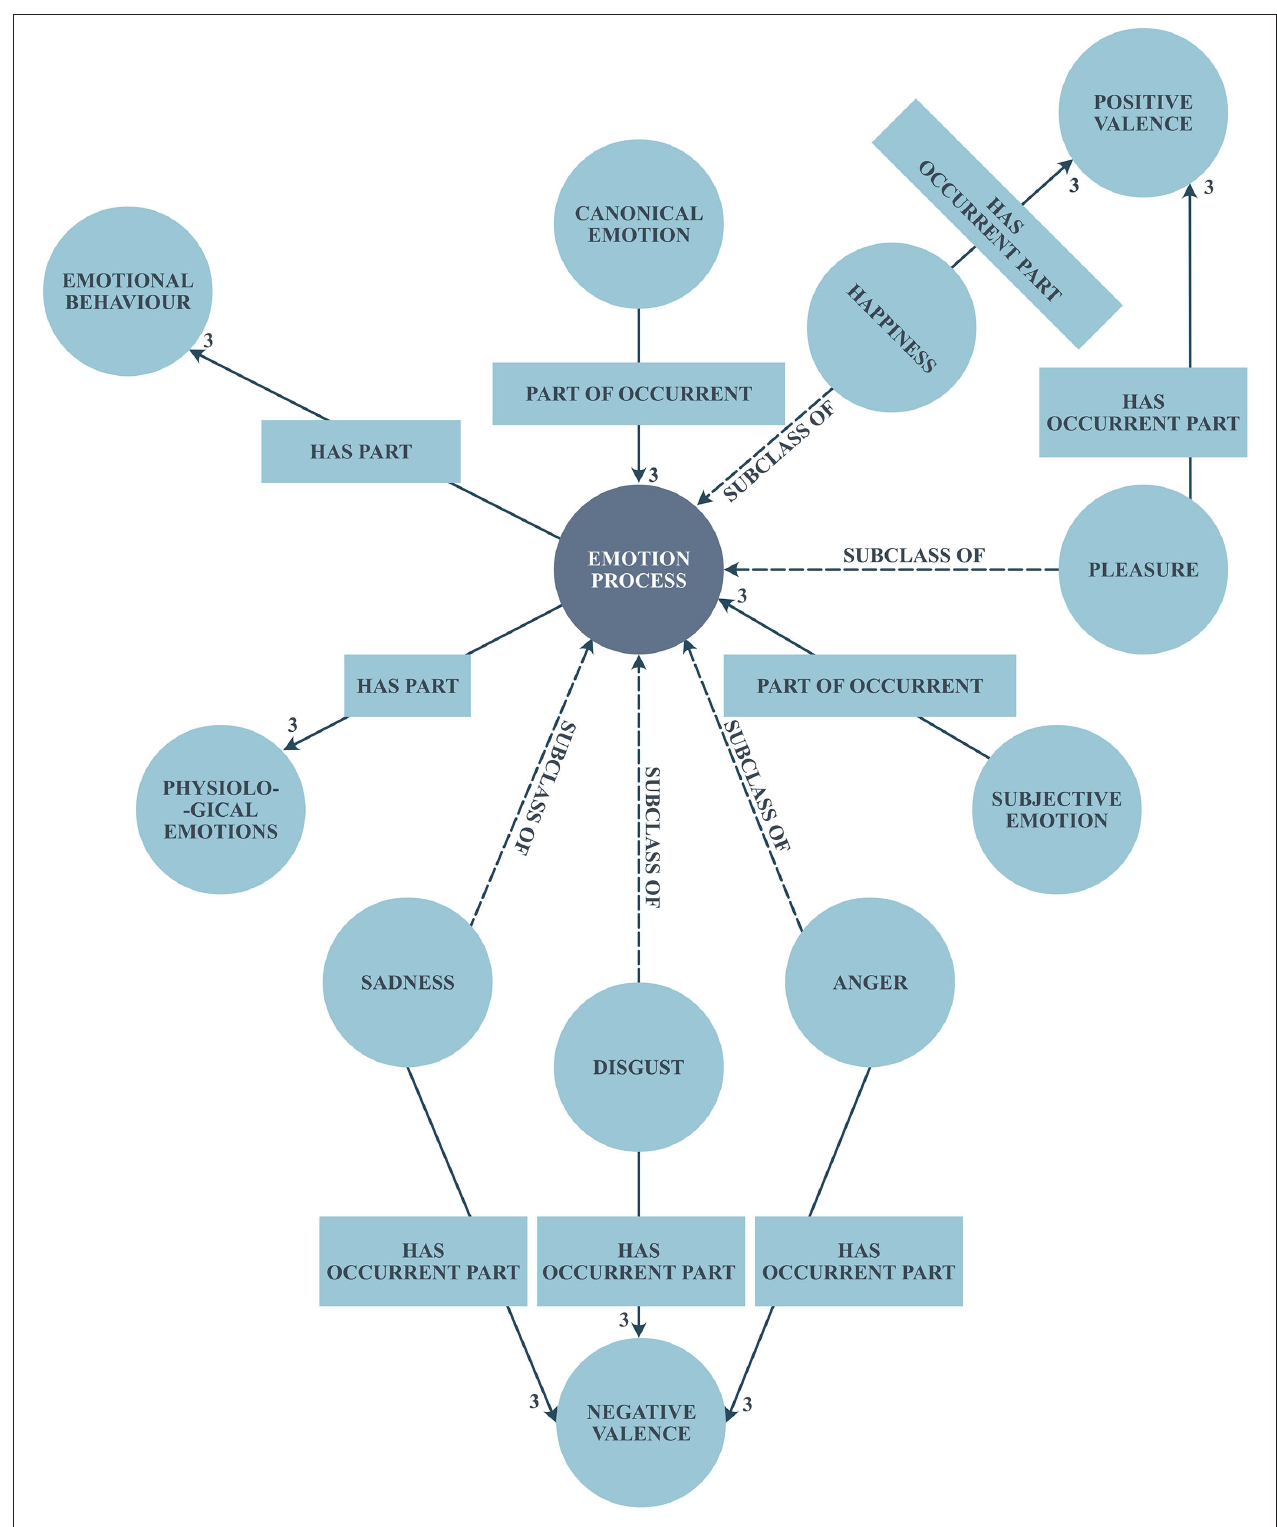
FIGURE 3 | Emotion ontology